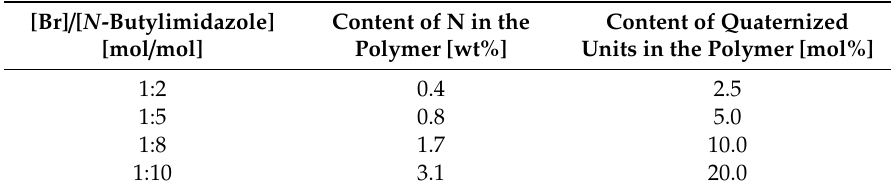
Table 1. Conditions and results of PTMSP quaternization (T of reaction = 55 ◦ C,